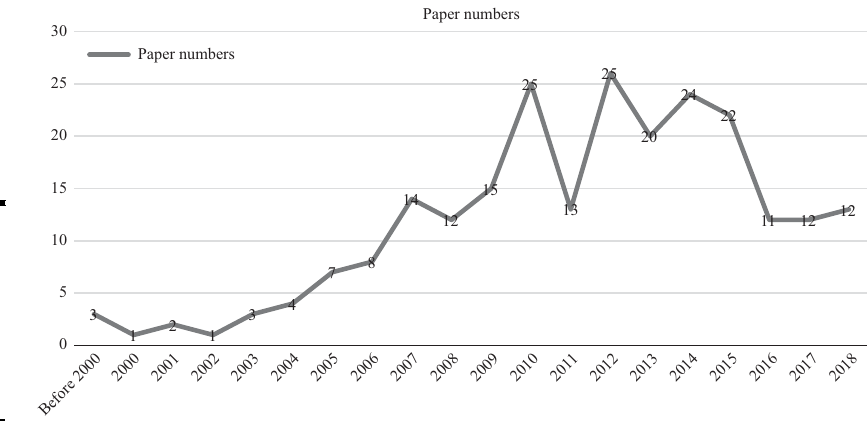
Figure 2. Distribution